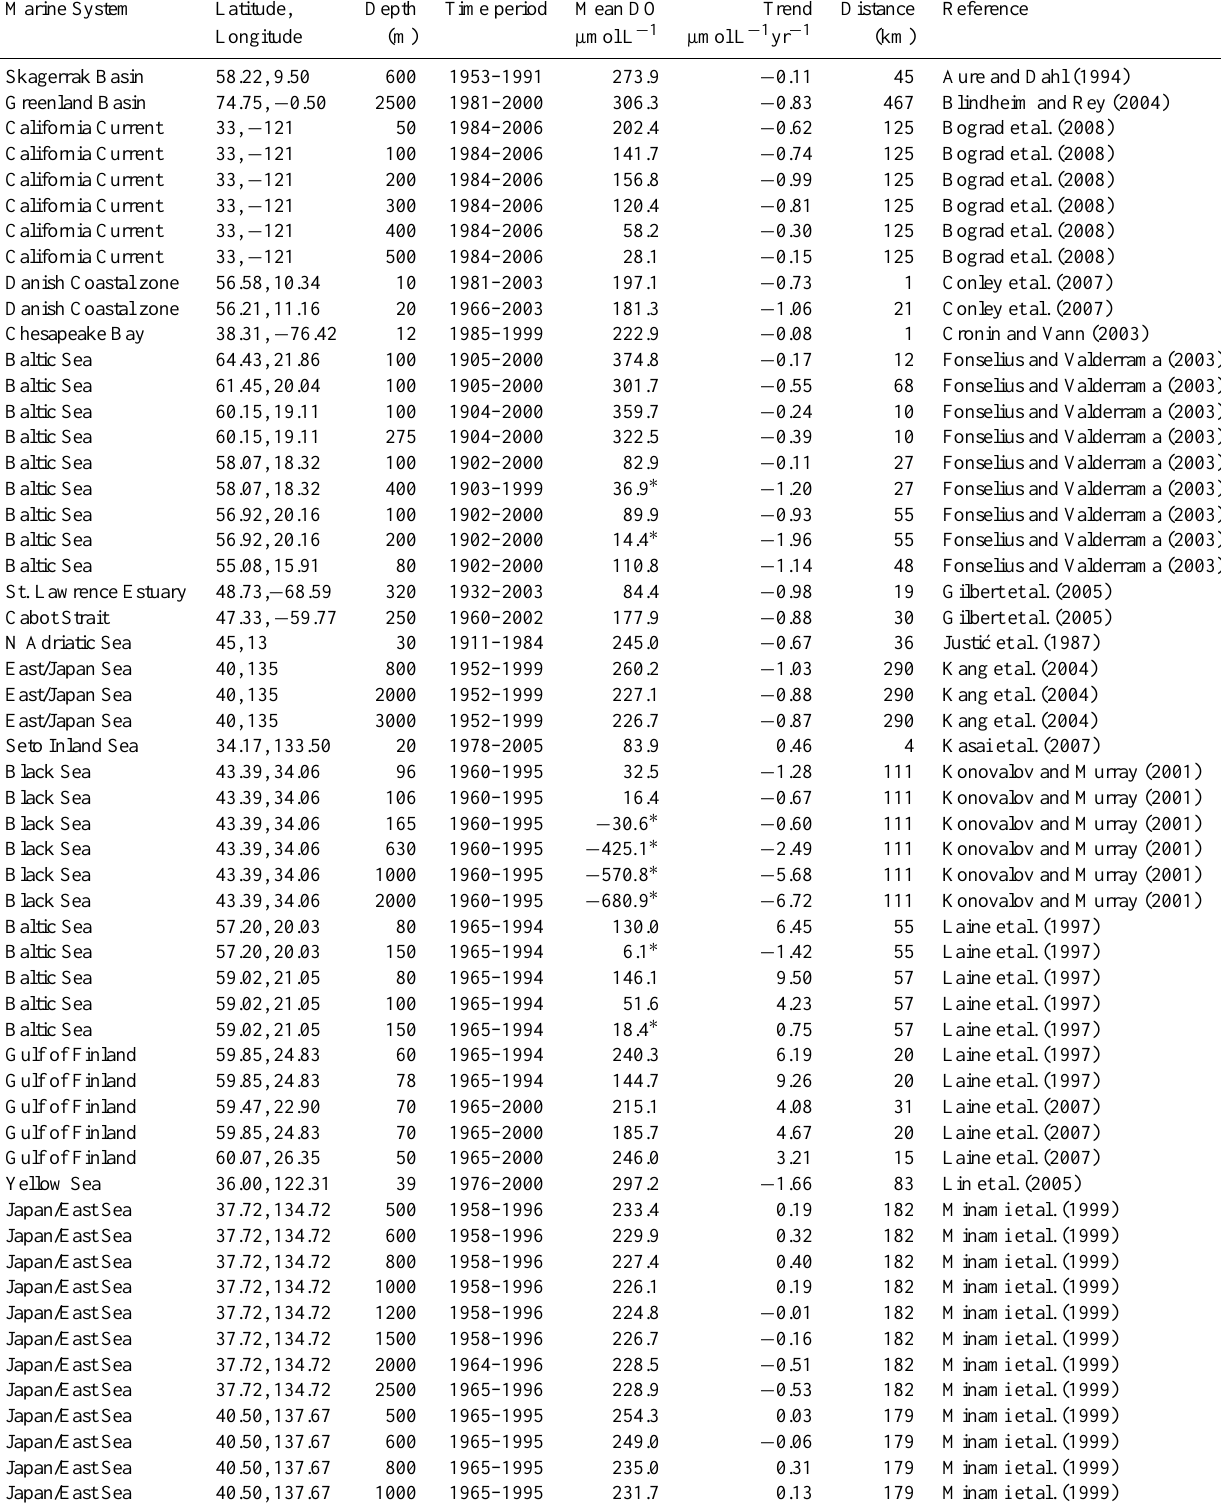
Table 2. List of refereed journal publications from which we obtained oxygen trends, or from which we digitized oxygen time series and then calculated trends. We could not calculate mean DO for two papers in which the oxygen time series were plotted as anomalies. Time series with negative oxygen values (due to the presence of H 2 S) are indicated with an asterisk in the mean DO column. Distances are relative to the nearest